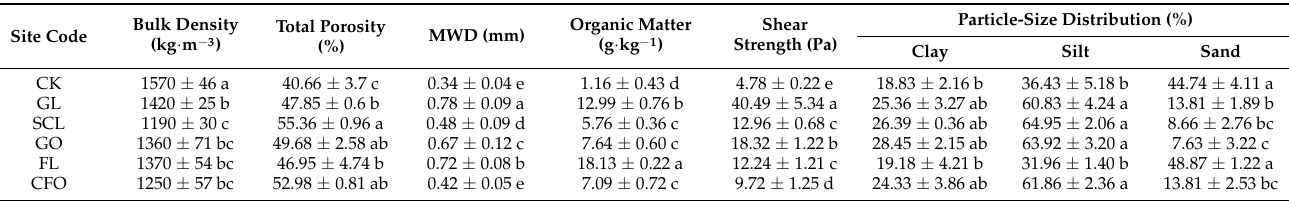
Table 2. Soil properties of different land of use types.